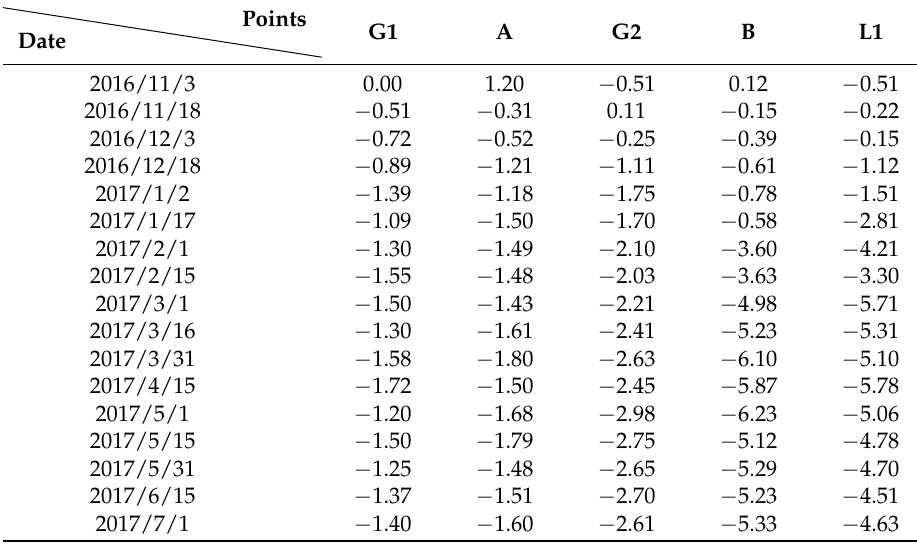
Table 5. Monitoring results unit: mm.